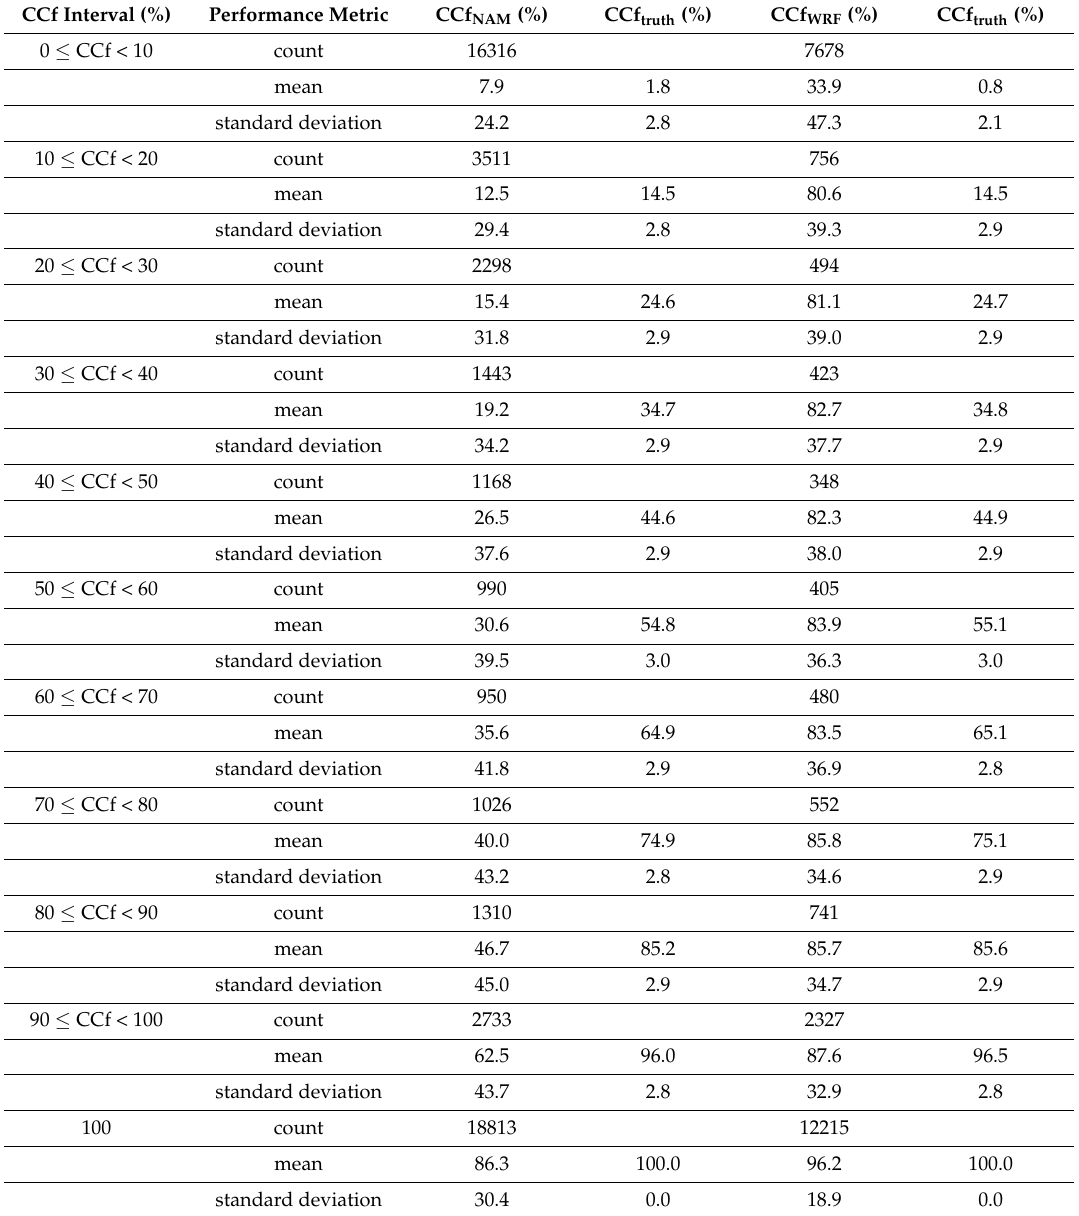
Table 1. Comparisons between respective CCf truth data and all clouds in NAM data at 1800 UTC on 18 November 2014 (CCf NAM ) as well as the maximum cloud cover fraction in WRF 24 h forecast profiles generated from these NAM data and valid at 1800 UTC on 19 November 2014 (CCf WRF